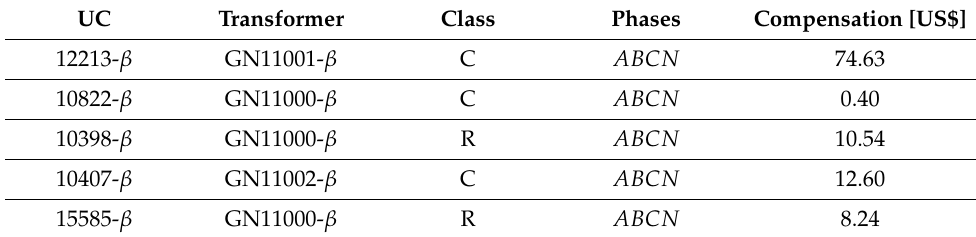
Table 8. Partial identification of simulated feeder- β UCs.